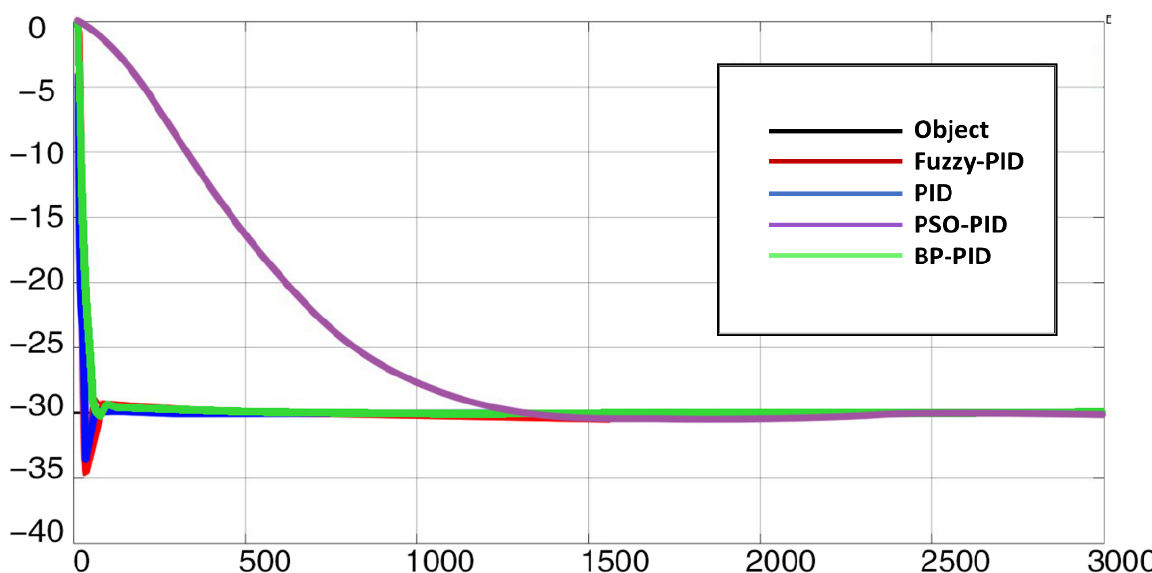
Figure 13. Heating response curve of the controlled object.